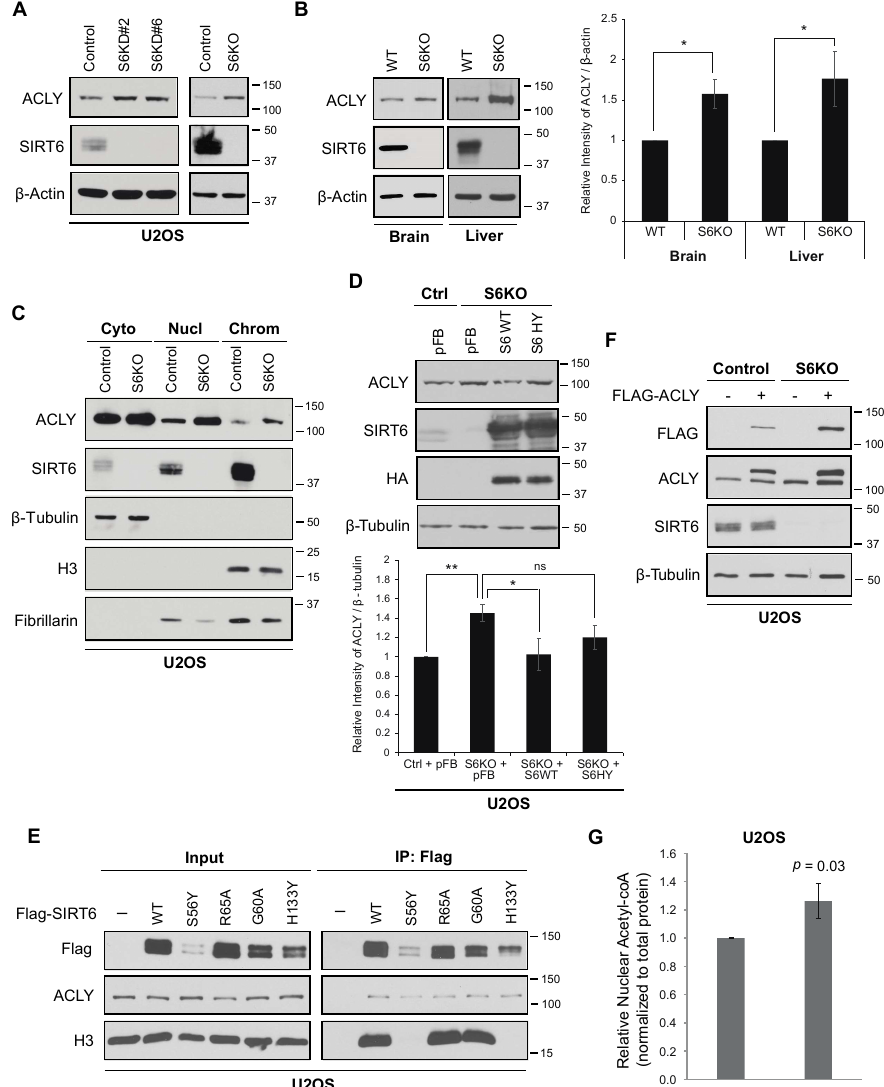
00.20.40.60.811.21.41.61.82 Figure 1. ACLY level increases with SIRT6 depletion. ( A ). Increased ACLY protein levels in SIRT6-deficient U2OS cells generated by knockdown (KD) or Crispr/Cas9-mediated knockout (KO). ( B ). Increased ACLY protein expression in SIRT6 KO mice tissues with quantification (Mean ± SEM of three experiments, * p < 0.05, one-tailed Student’s t -test). ( C ). Sub-cellular fractionation showing increased levels of nuclear and chromatin ACLY in SIRT6 KO cells compared to controls. β -tubulin, fibrillarin, and Histone H3 are shown as markers for the cytoplasmic, nuclear, and chromatin-enriched fractions. ( D ). Increased ACLY in SIRT6 KO cells reversed by overexpression of SIRT6 WT but not SIRT6 HY mutant with quantification (Mean ± SEM of three experiments, * p < 0.05; ** p < 0.01; ns: not significant, one-tailed Student’s t -test). pFB, empty vector control. ( E ). Co-IP of ACLY with Flag- tagged wild-type (WT) and catalytically inactive SIRT6 proteins overexpressed in U2OS cells. The S56Y and H133Y mutations abolish SIRT6 catalytic activity, whereas R65A and G60A have partially impaired deacetylase and ADP-ribosyl transferase activities. The Histone H3 levels show chromatin association of the SIRT6 proteins. ( F ). Increased abundance of Flag-ACLY and endogenous ACLY protein in SIRT6 KO cells. ( G ). Relative nuclear Acetyl-CoA levels in control and SIRT6 KO cells, normalized to total protein (Mean ± SEM of seven experiments, two-tailed Student’s t